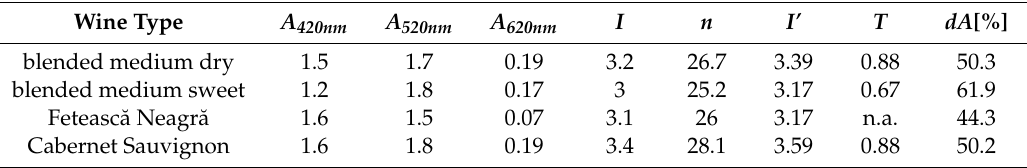
Table 3. Red wine absorption spectrum magnitudes and the estimated wine color measures, determined with the point intra-oral sensor.